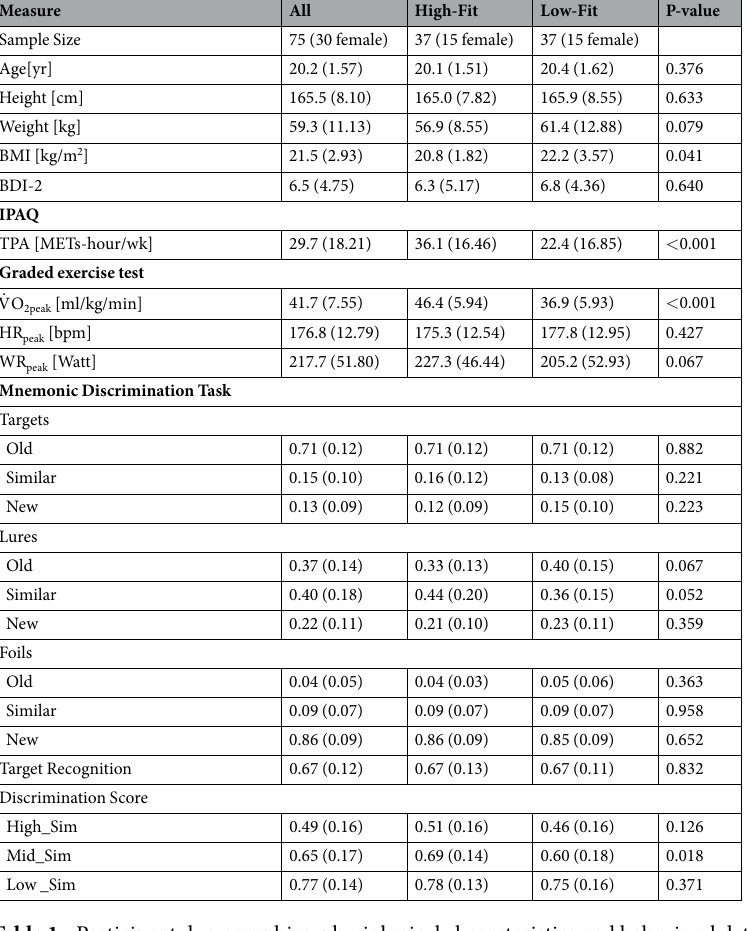
the retrieval phase, during which a series of 256 items were randomly displayed on a monitor and participants identified each item as “old”, “similar”, or “new” by pressing buttons. One-fourth of the stimuli in the retrieval phase were “old”, or exact repetitions of stimuli presented in the encoding phase (64 targets); half of the stimuli